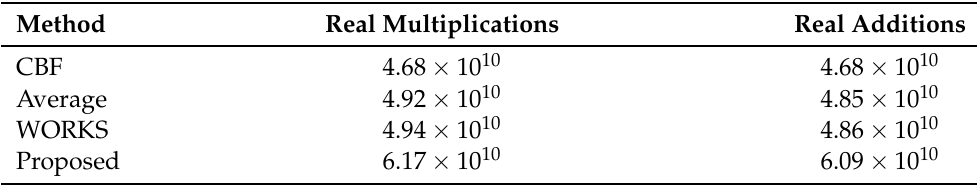
Table 1. The comparison of calculation